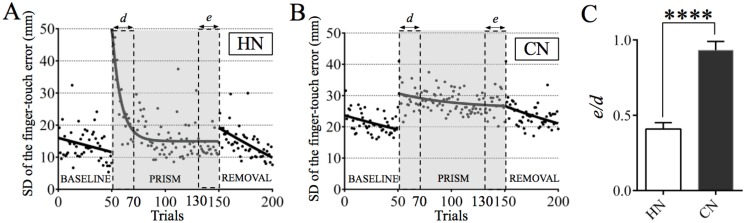
Variability of the finger-touch error in HN and CN groups.(A) Variability of the finger-touch error in 21 HN subjects. Each dot shows SD of the finger-touch error for every trial throughout BASELINE, PRISM, and REMOVAL. An interpolated curve was drawn by fitting with nonlinear regression. (B) Same analysis as (A) in patients with cerebellar diseases below 70 years old (CN). (C) Comparison of intertrial variability of the finger-touch error shown in A and B between the initial 20 and the last 20 trials. The ordinate shows the ratio (e/d) of the mean SD for the last 20 trials (e) in PRISM to that for the initial 20 trials (d) of PRISM. Note that the intertrial variability markedly decreased following adaptation in the HN group, but not in the CN group. **** p < 0.0001 by Mann-Whitney U-test. Error bar represents SEM.